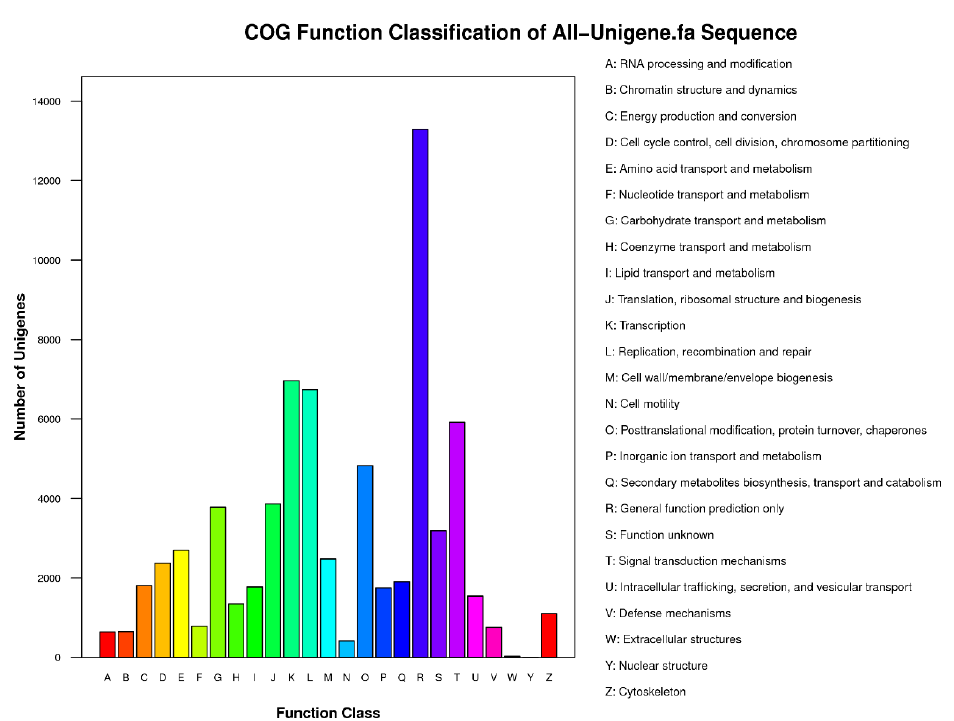
Figure 3. Functional classes of unigenes based on the Cluster of Orthologous Group